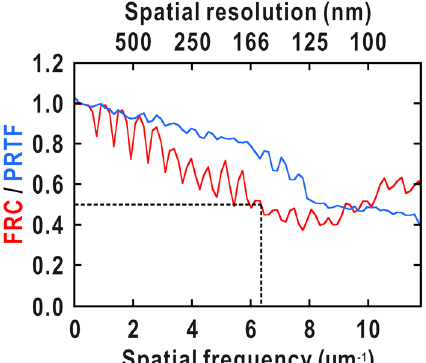
Fig. 11 Assessment of the effective spatial resolution of the moving object imaged using multiple-shot coherent diffraction imaging. The Fourier ring correlation (FRC) and phase retrieval transfer function (PRTF) curves are depicted by the red and blue solid lines, respectively. The broken line indicates a threshold of 0.5 and corresponding